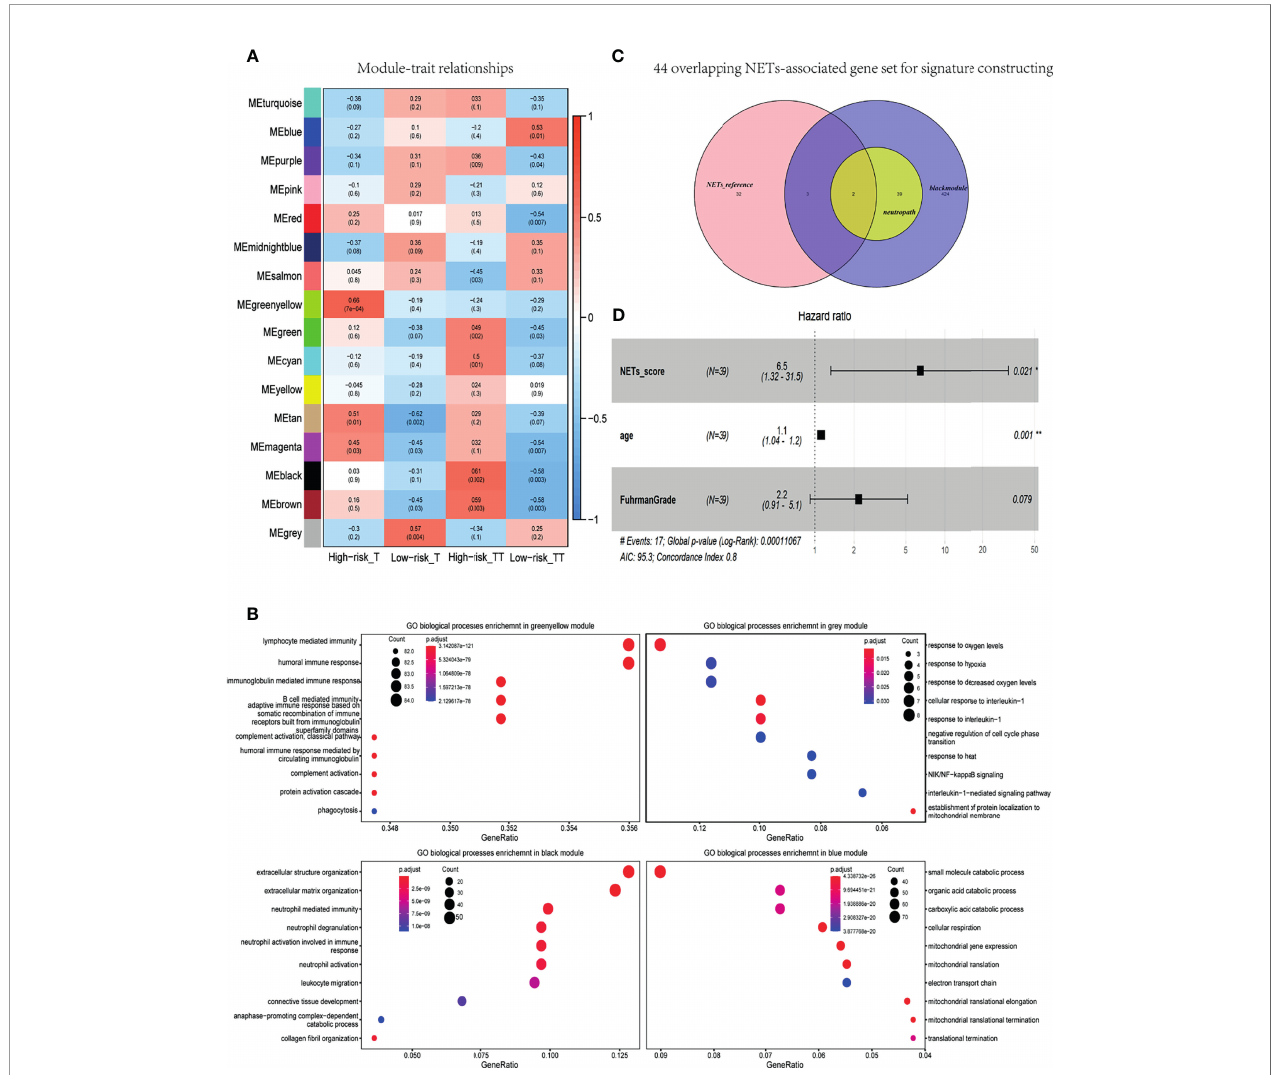
FIGURE 3 | NETs-score was an independent prognostic factor for localized RCC with tumor thrombus. (A) Heat map of module-trait associations; rows represent the module eigengene, and columns represent clinical traits. (B) Dot plot of the biological process enrichment results in the black module. The dot size and color represent the gene count and enrichment level, respectively. (C) Venn diagram of the 44 overlapping genes were converged in the NETs-associated gene set for signature constructing. black module: 486 genes were found in the black module; neutropath: 41 genes in neutrophil-characteristic GO-terms in this black module; NETs-reference: a summary gene set of NETs-associated genes in prior research. (D) Forest plot of pooled HRs and 95% CI for OS in the TCGA validated